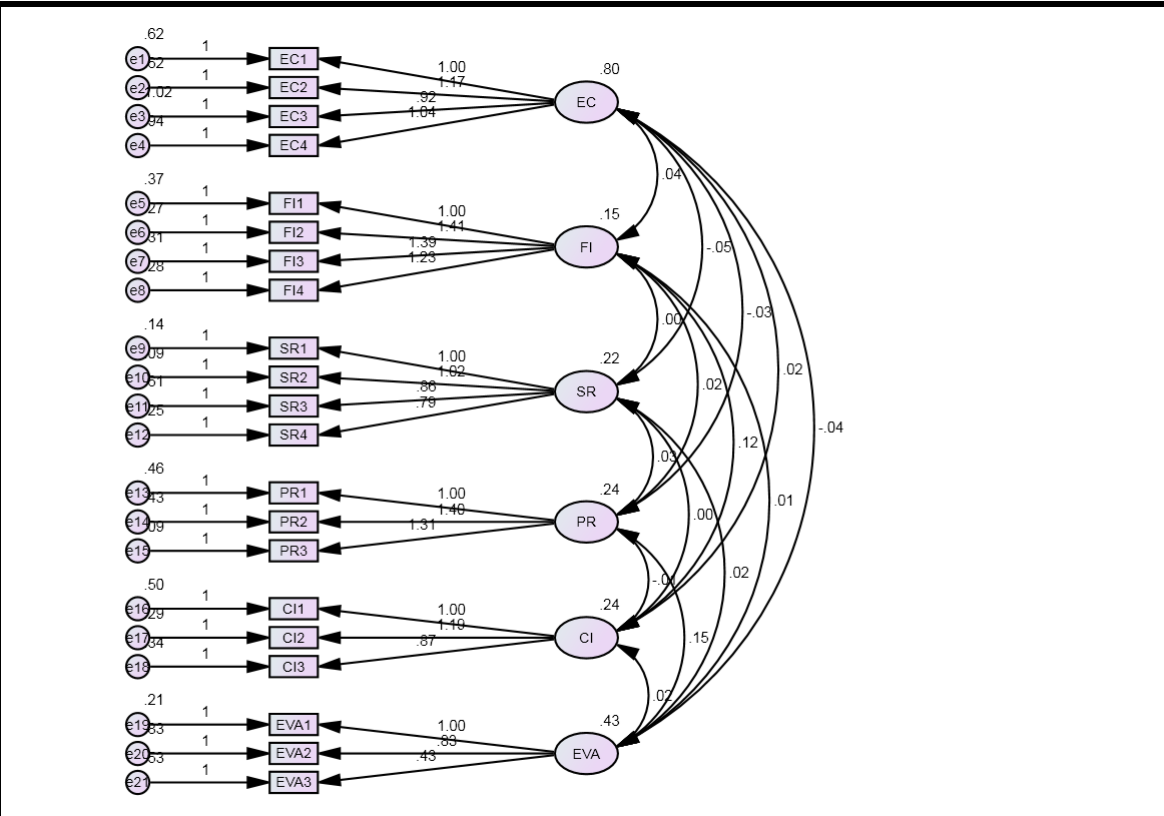
Figure 2. Model Fit. Figure 2. Model Table 6. Hypotheses Conclusion.